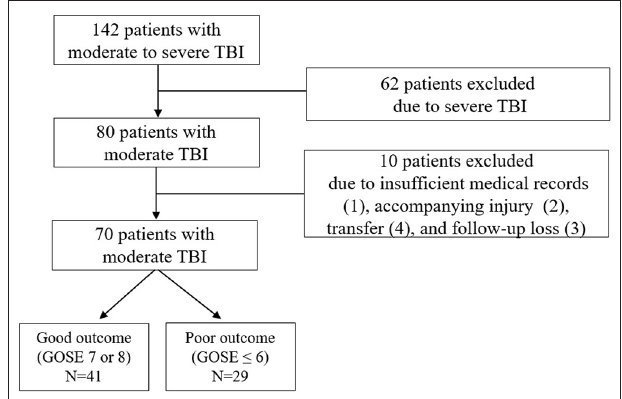
FIGURE 1 | Flow diagram of the study. GOSE, Glasgow Outcome Scale Extended; and TBI, traumatic brain injury.